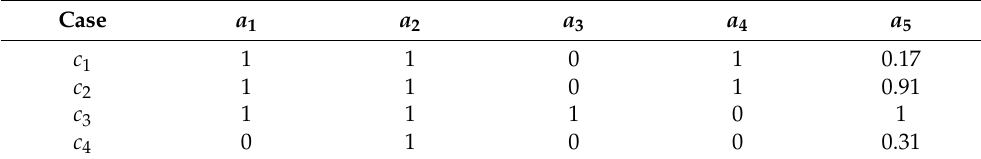
Table 11. Local similarity between c i and nc.